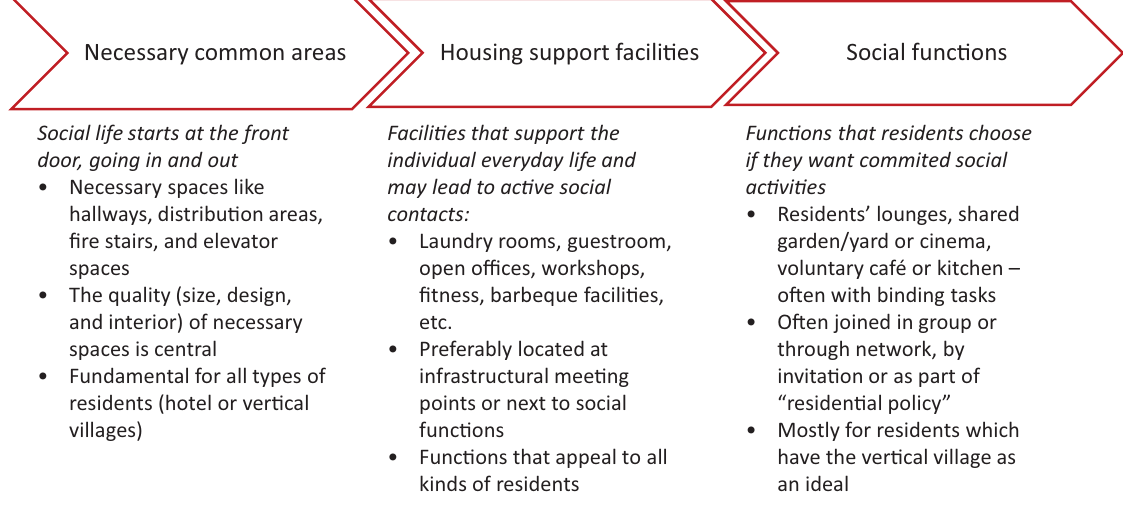
Figure 6. Steps in establishing vertical neighborhoods. This study shows that establishing vertical neighborhoods in Danish high‐rises is deeply home‐centered. Social practices start at the front door and are something you bring with you (or not). Housing support facilities make everyday life routines possible and are mediators of informal social interactions (second step). Social spaces are mostly for residents who expect a high level of community (third